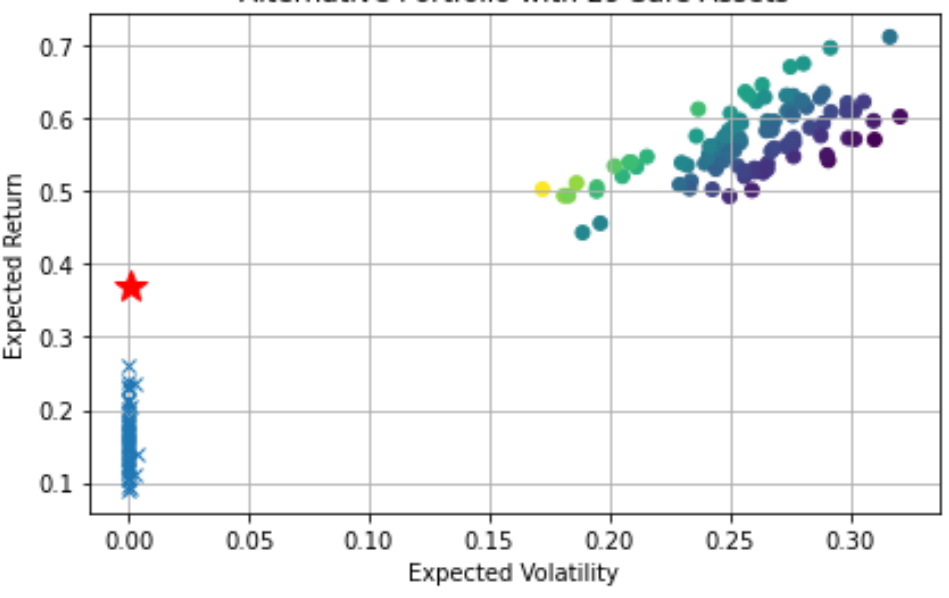
Figure 23. Alternative portfolio optimization: Monthly expected risk and